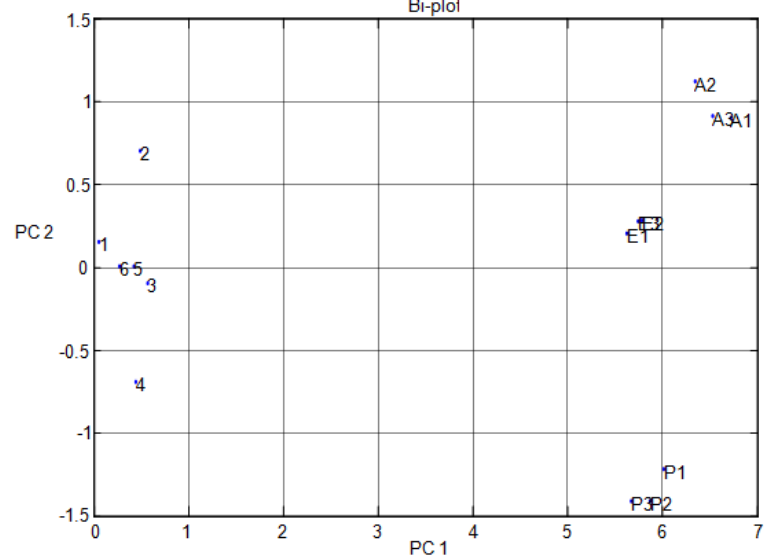
Figure 6. Multivariate technique on organic gases for different features in the Bi design.